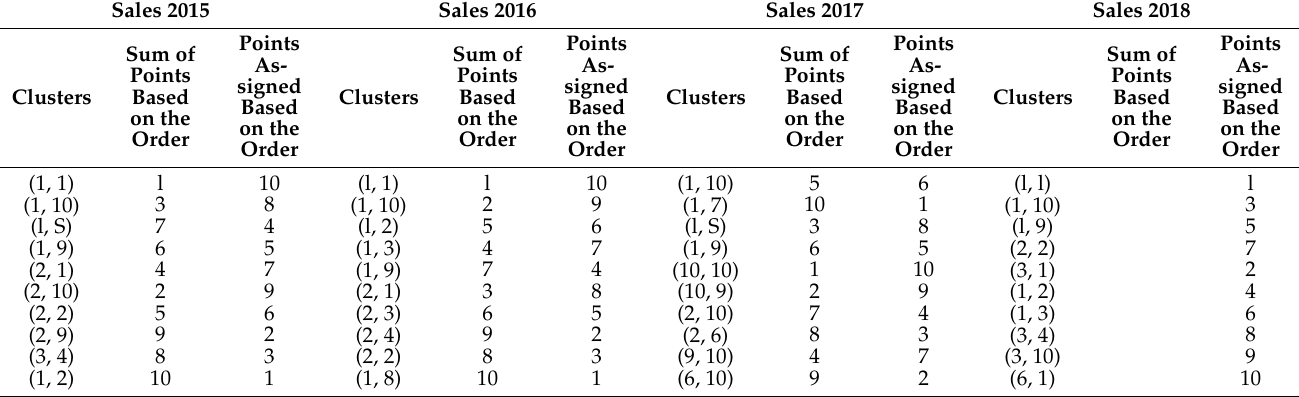
Table 27. Evaluation of clusters based on their order—years 2015–2018 (Sales).